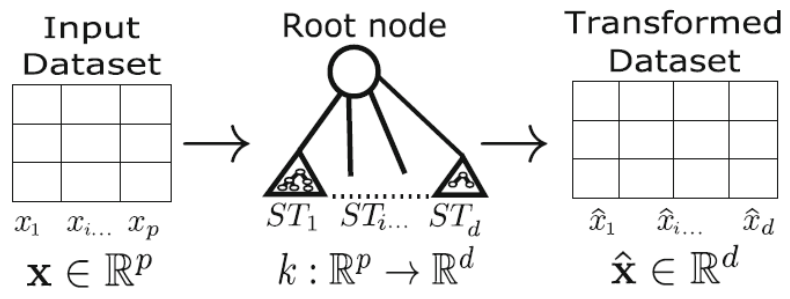
Figure 3. The special tree with d dimensions stemming from the root